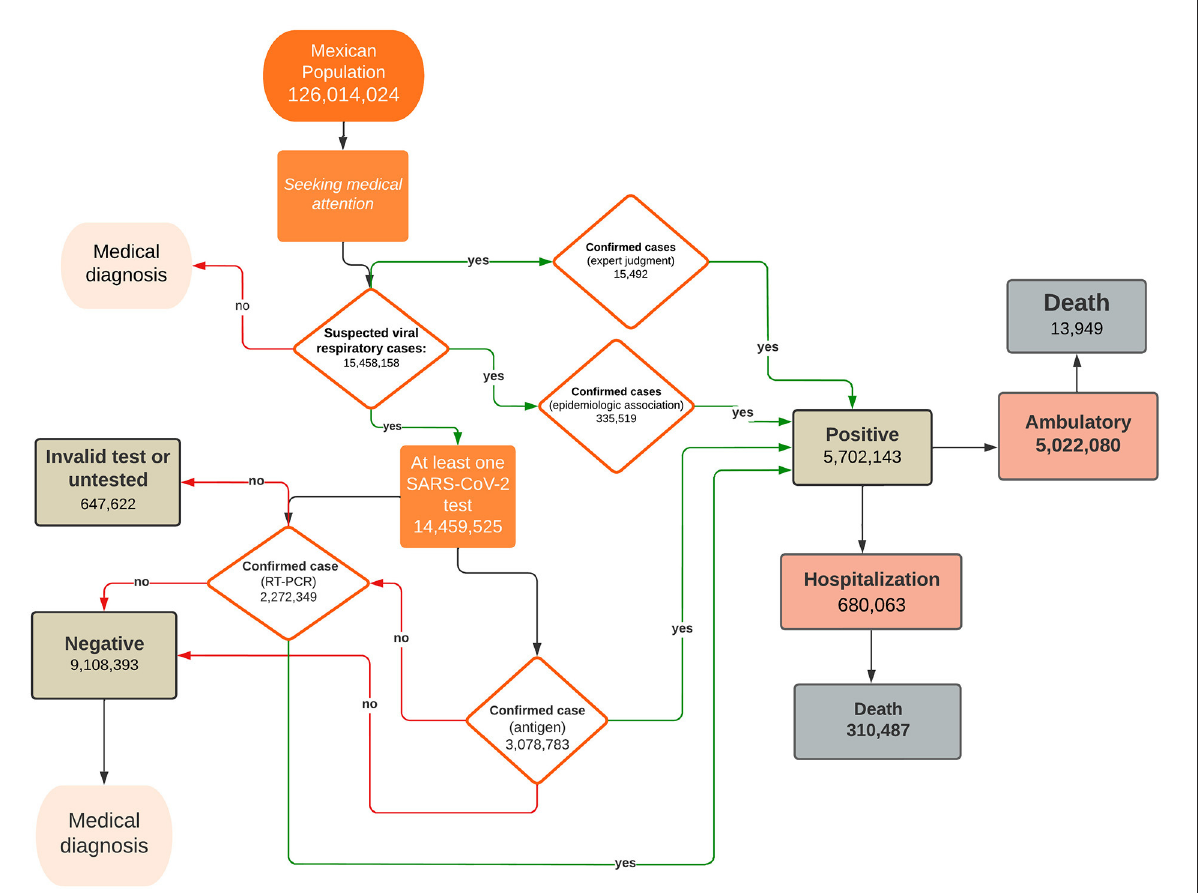
FIGURE1 Follow-up of suspected COVID-19 cases reported in the SISVER database. The diagram shows suspected cases of viral respiratory disease and their evolution path. A fraction of the patients with a negative antigen test were tested by